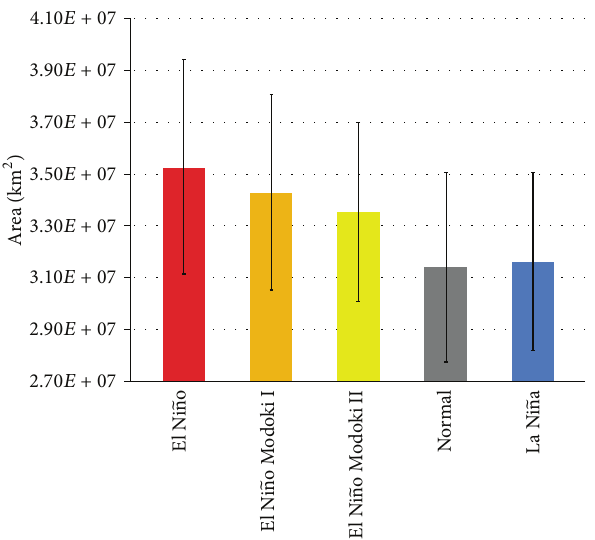
Figure 6: The average WPWP area in the five events. The bar represents one standard deviation.